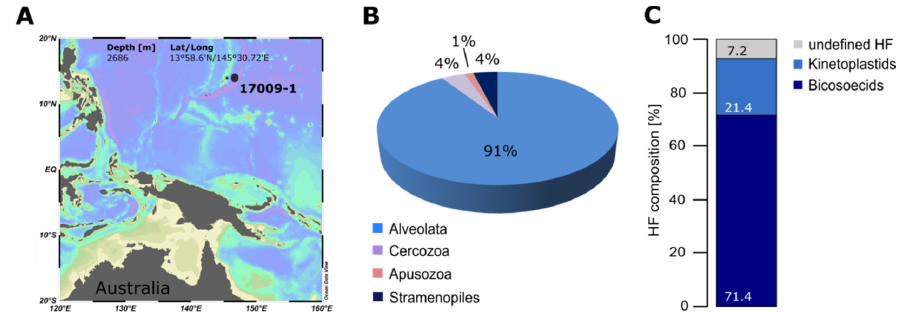
Figure 3. Comparison of methods applied for investigations of deep-sea heterotrophic flagellates in the Mariana Basin, Central Northern Pacific. ( A ) Position of the sampling station (2686 m depth), R/V Sonne I (SO223T, 09.09.2012–10.10.2012). Created with Ocean Data View [37]. ( B ) Percentage contribution of sequence reads of HF groups obtained by 454 sequencing. ( C ) Percentage contribution of HF groups revealed with the liquid aliquot method. NGS: Whole genomic DNA extracted from sediment samples using the PowerSoil ® DNA isolation kit (Mo Bio Laboratories, Inc., Carlsbad, CA, USA) and quantified using a spectrophotometer. The highly variable V4 region of the 18S rRNA gene was directly amplified from the samples using the eukaryotic specific primers 590F (5 1 -CGGTAATTCCAGCTCCAATAGC-3 1 ) and 1300R (5 1 -CACCAACTAAGAACGGCCATGC-3 1 ). Each sample was PCR’ed in triplicate